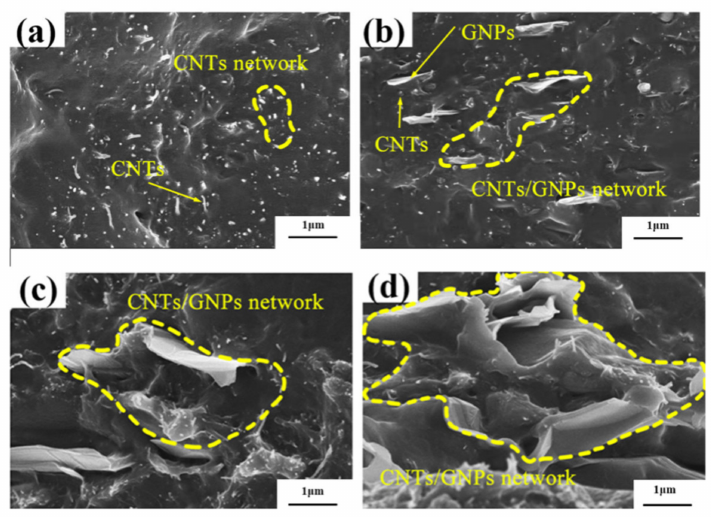
Figure 1. SEM images of CNT/GNP/EUG composites: ( a ) ECG0; ( b ) ECG1; ( c ) ECG2; ( d ) ECG3.